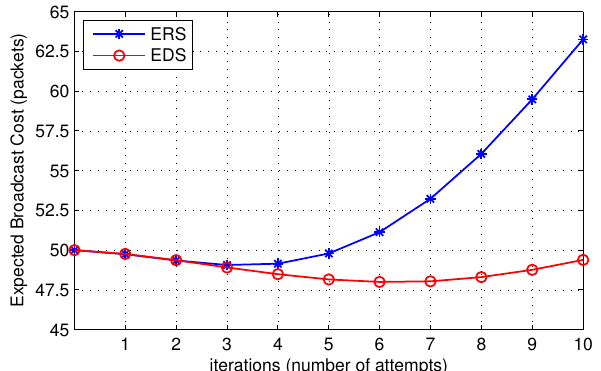
Figure 14. Expected broadcast cost for route